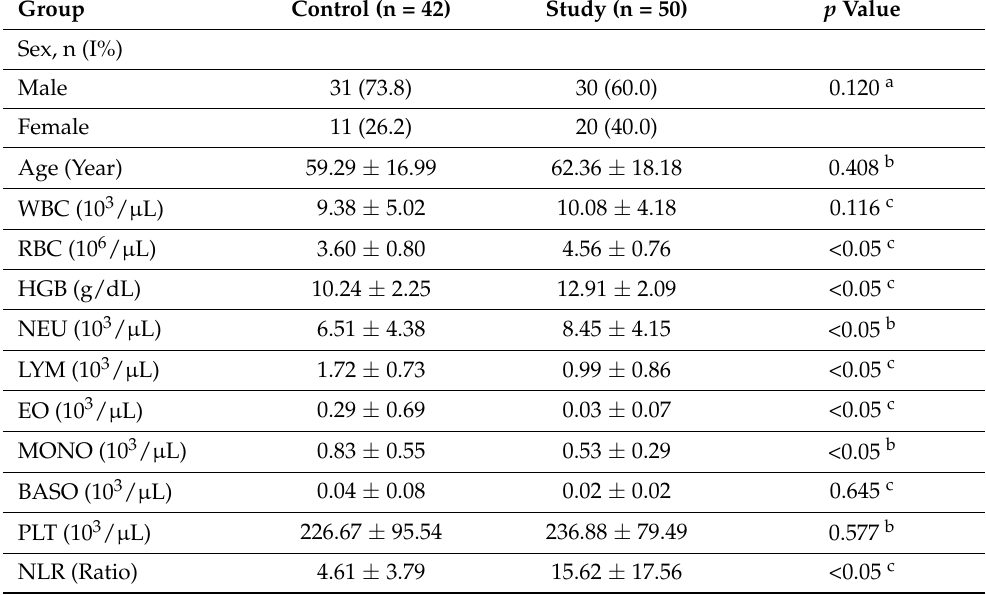
Table 1. Baseline and clinic characteristics of patient groups.